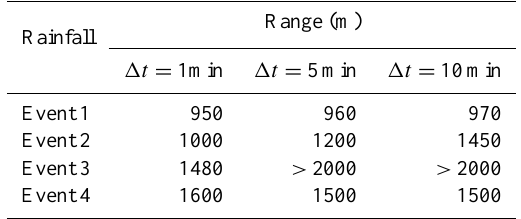
Table 5. Range derived from experimental semi-variograms for dif- ferent temporal aggregations, for all four